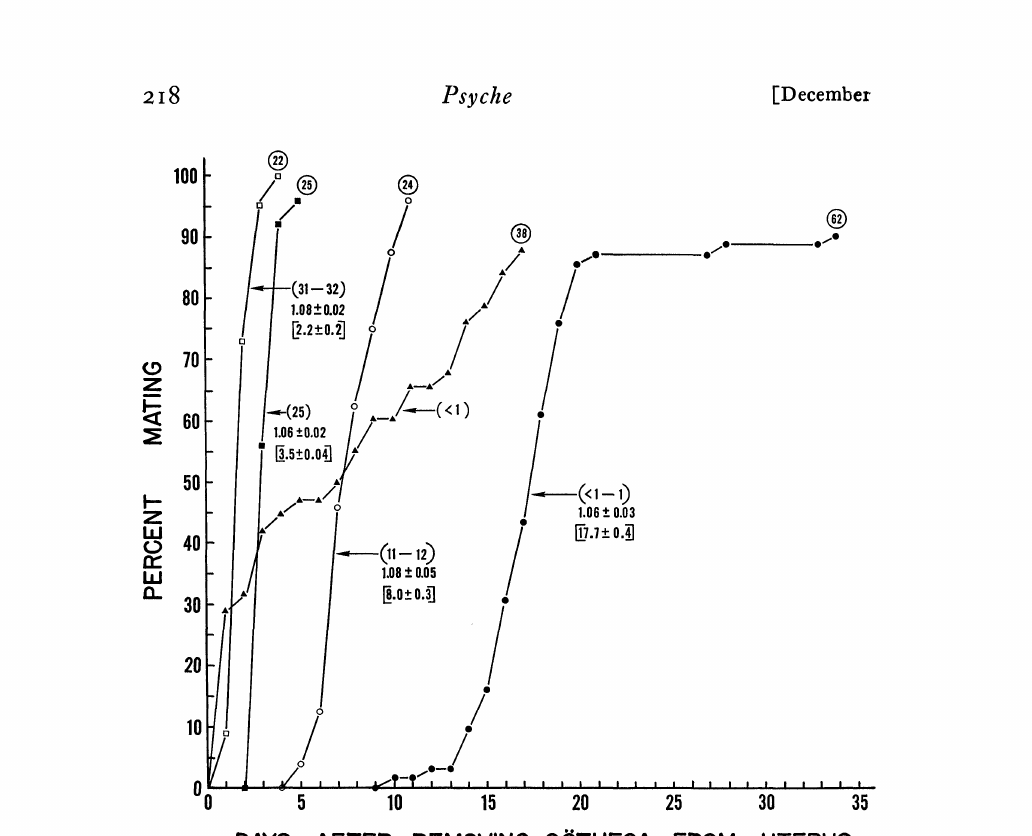
Fig. 12. Relationship between age of o6theca when removed fro.m the uterus, and recovery of receptivity in N. cinerea. Numbers in circles number of insects used. Numbers in parentheses number of days females were pregnant when their o6thecae were removed. Numbers under the parentheses mean length (mm.) _+ standard error of the oicytes meas- ured <24 hr. after mating. Numbers in brackets mean days standard error for return of receptivity. Solid triangles virgin females; all other groups had mated prior to ovipositing. All females with males continuously until they mated; females examined daily for spermatophores. The per cent mating is expressed as accumulative